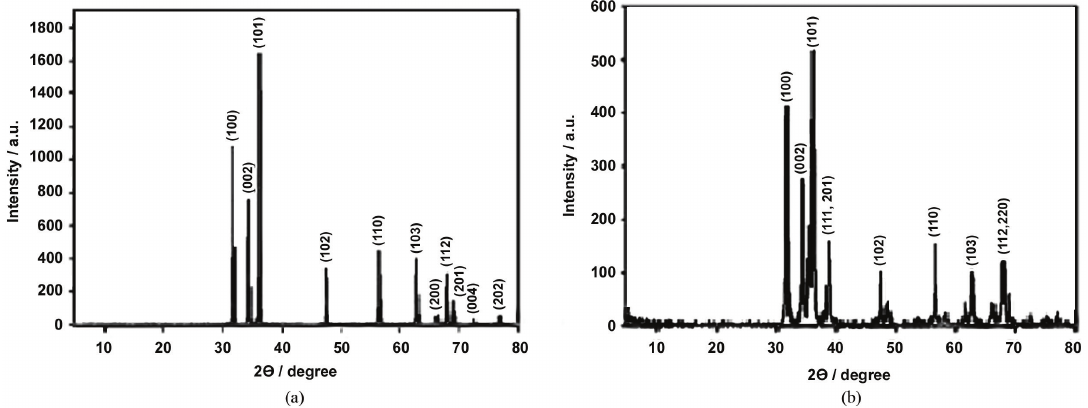
Figure 5. XRD pattern of (a) ZnO (b) ZnO-CuO deposited at 750